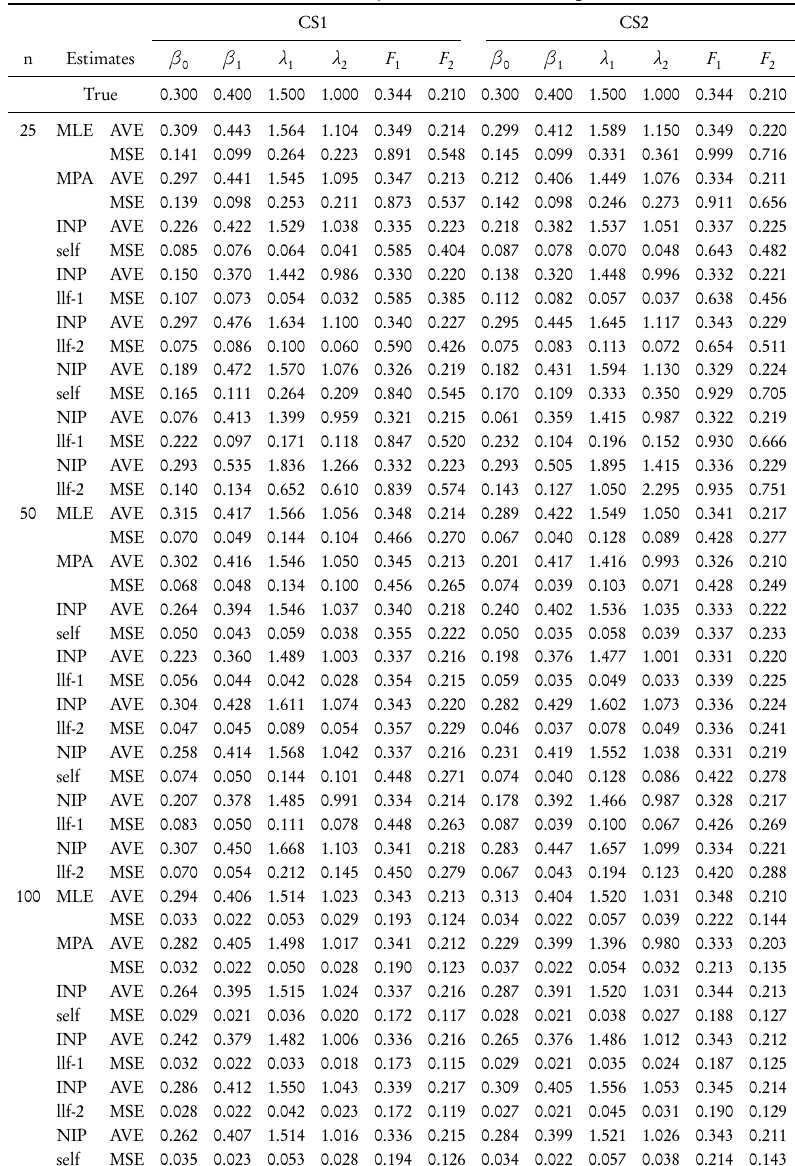
AVE and MSE values of the estimates are